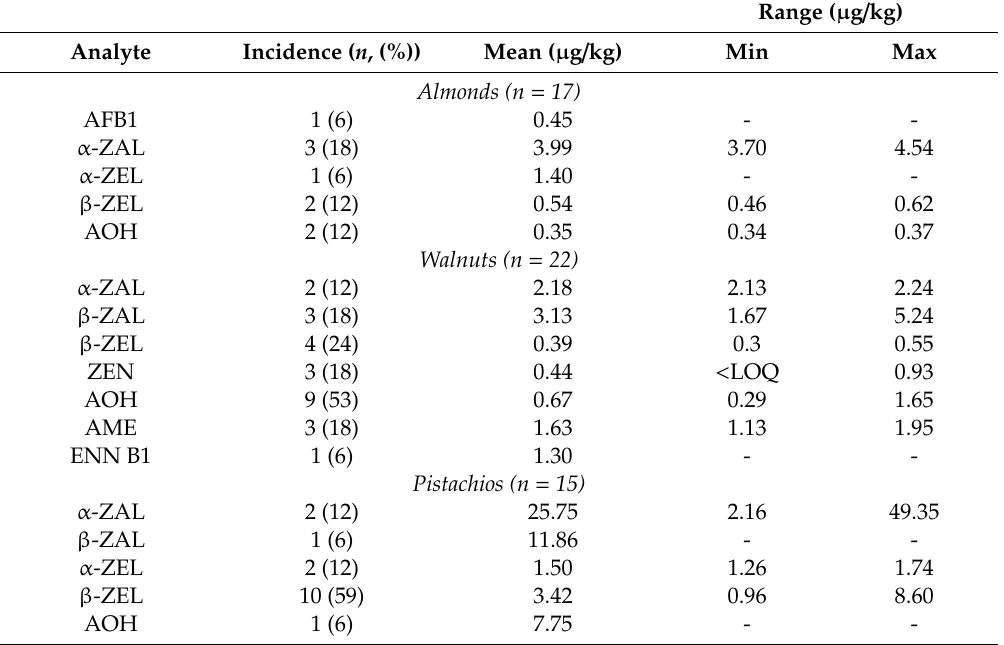
Table 3. Occurrence of mycotoxins in the analyzed tree